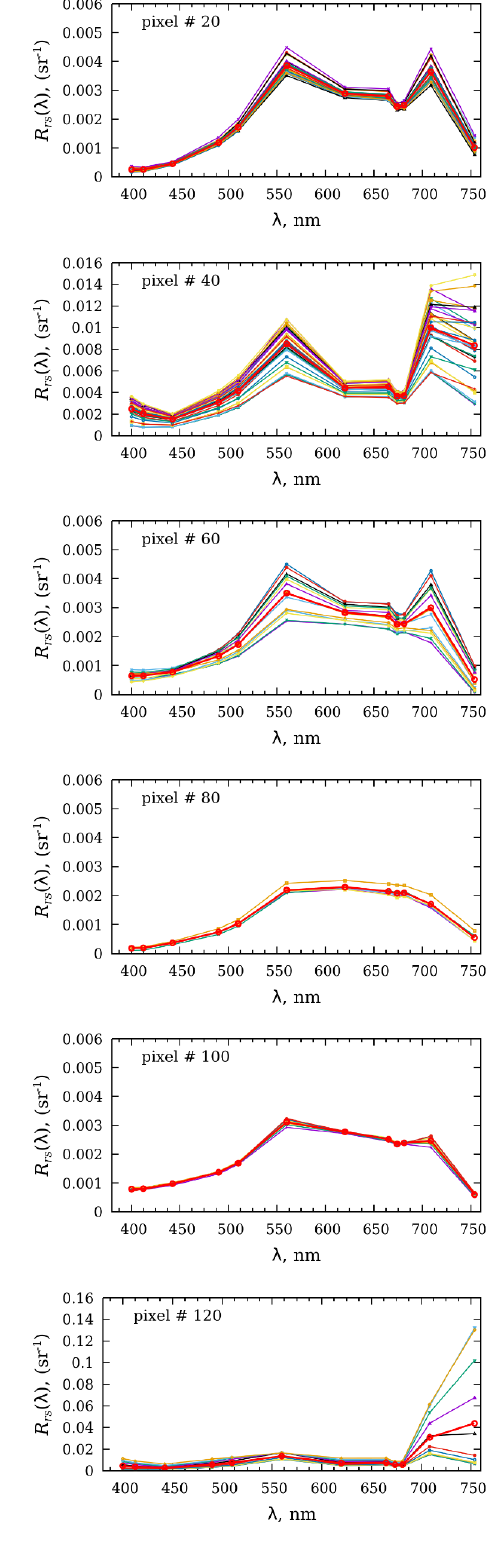
Figure 6. Spectral variations of in situ R rs measured along the motorboat route in pixels marked in Figure 5c. The bold red and thin colored lines correspond to pixel-averaged R rs spectra and R rs spectra measured within OLCI image pixel,